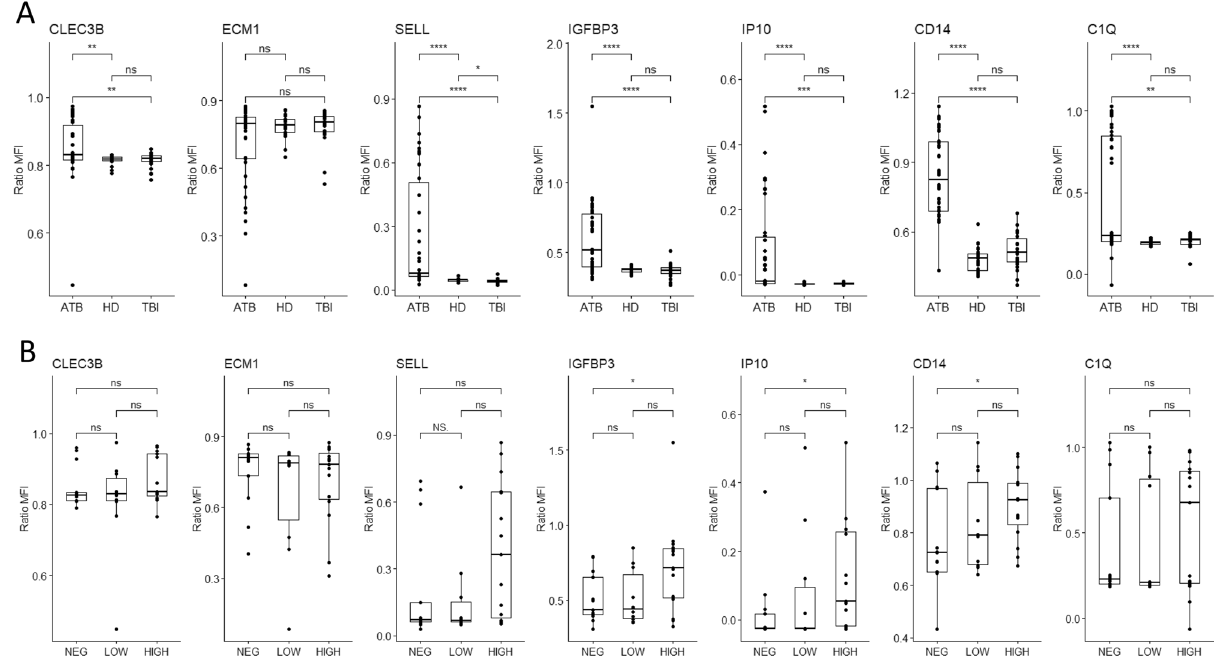
Figure 1. Evaluation of single host protein markers related to clinical group and mycobacterial load variations. ( A ) Comparison of markers expression in different clinical groups. ( B ) Comparison of markers expression and mycobacterial load variation. Data are given as median + interquartile range. Each black dot represents one patient. Data were compared using the Mann–Whithney U test with correction apply to adjust p